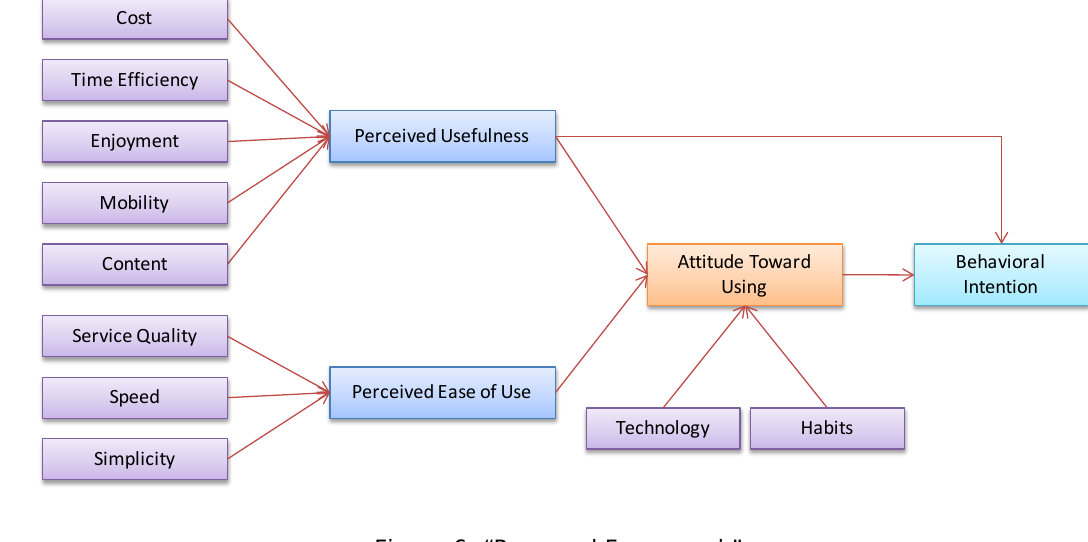
Figure 6. “Proposed